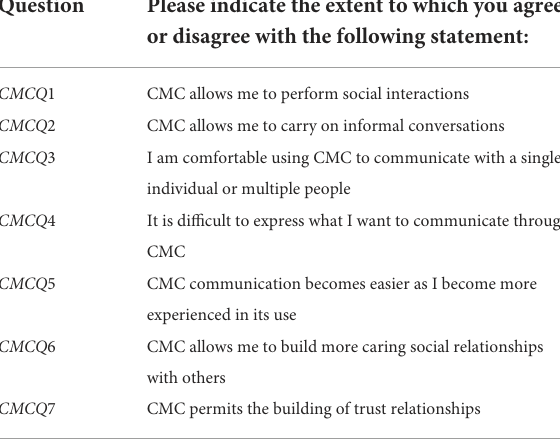
TABLE 2 Computer mediated communication questionnaire. Question